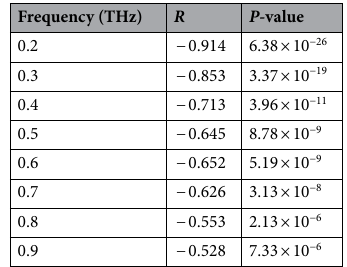
Table 1. Results of statistical analysis results summarizing the p -value and Pearson correlation coefficient between the THz absorption and the TG